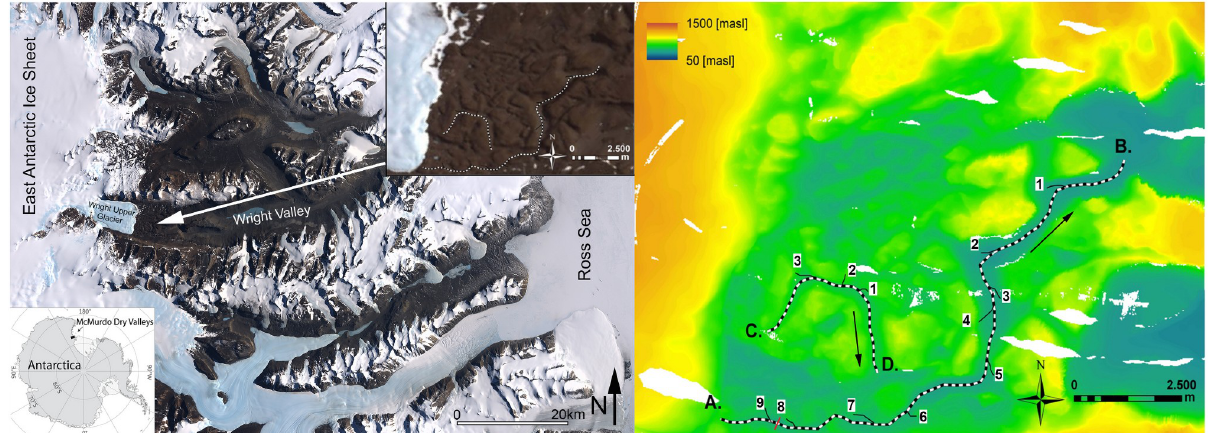
Fig 1. Left: Satellite image of the Dry Valleys region derived from the Landsat Image Mosaic of Antarctica (LIMA). The Labyrinth is indicated with a white arrow. Inset at bottom left shows location of the Dry Valleys in Antarctica. Inset at the top right shows a close up of the Labyrinth with the two channels presented in this study highlighted in white. Right: Digital Elevation Model extracted from LiDAR data showing the axis of two subglacial cannels (channel A-B and C-D). Confluences of smaller channels into the two channels are indicated with numbers. In red the cross section used in the model. The black arrows indicate the flow